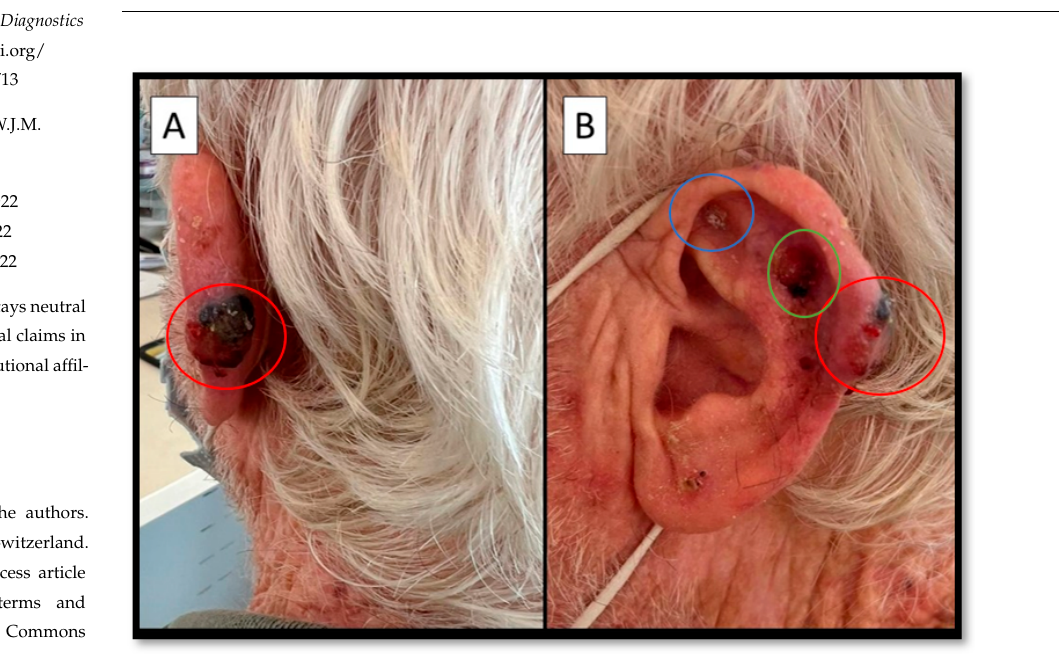
Figure 1. ( A , B ) Posterior and lateral view of an infiltrated nodule, hard on palpation, black and surmounted by a large ulcerative-necrotic area (red circle). In ( B ) two other, different, lesions are apparent (blue and green circles). A 73-year-old man presented at the Plastic Surgery Complex Operative Unit because of the appearance of a lesion that was present from more than two years before, at the level of the left helix, measuring about 18 × 12 mm (red circle, Figure 1), with an ulcerated area on the surface. The medical history was negative for other pathologies and / or neoplasms. After a plastic surgery specialist consultation, the decision was made to remove the lesion together with two other neighboring lesions (blue and green circles, Figure 1B). The samples were histopathologically analyzed. Figure 2. The histopathological evaluation showed a nodular lesion overlaying the auricular cartilage and extending to ulcerate the overlying epidermis (Hematoxylin-Eosin, Original Magnification 2× ( A ) and 4× ( B )). A diagnosis of polymorphic malignant melanoma (PMM) was made, with a vertical growth phase of tumorigenic type, up to 4.5 mm thick according to Breslow, with a number of mitoses / mmq> 1, as well as lymphovascular invasion, neurotropism, and microsatellitosis, staged according to the AJCC 8 ′ Edition as pT4b N1c. The sample was then subjected to molecular biology tests to search for mutations in exons 11 and 15 of the BRAF gene and in exons 2, 3, and 4 of the NRAS gene by RealTime PCR. This revealed a mutation in codon V600 of exon 15 of the BRAF gene (V600E / E2 / D). No mutations were detected in exons 2, 3, and 4 of the NRAS gene.